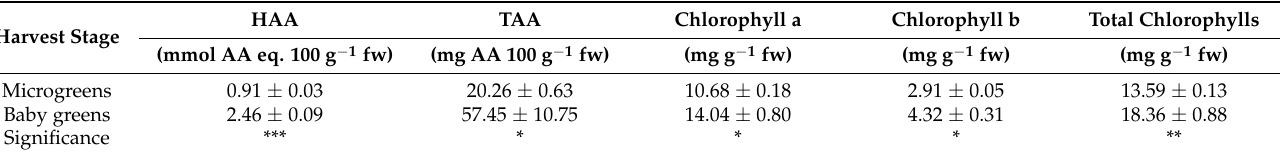
Table 2. Hydrophilic antioxidant activity (HAA), total ascorbic acid (TAA) and chlorophyll pigment of Petroselinum crispum by virtue of harvest stage.